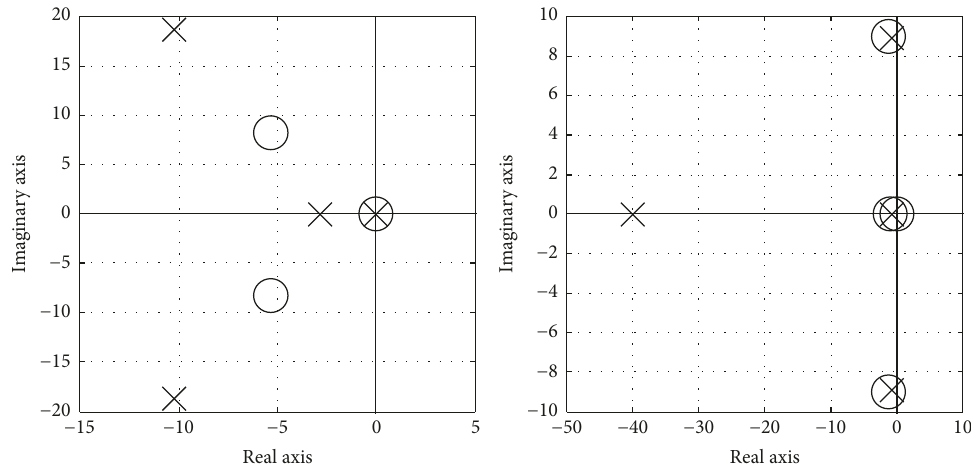
Figure 9: Robust H ∞ nonfragile control for vehicle body lateral acceleration. (a) Without perturbation. (b) With perturbation.